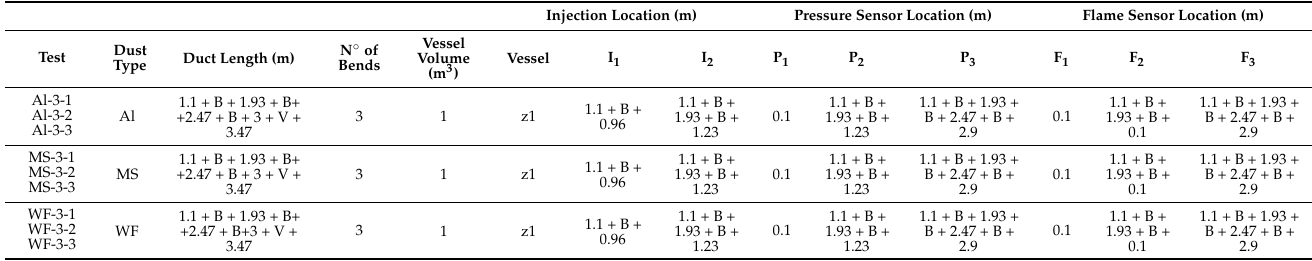
Table 3. Summary of the tests performed for the curved duct with a R/D ratio of 0.6 and 1.5.